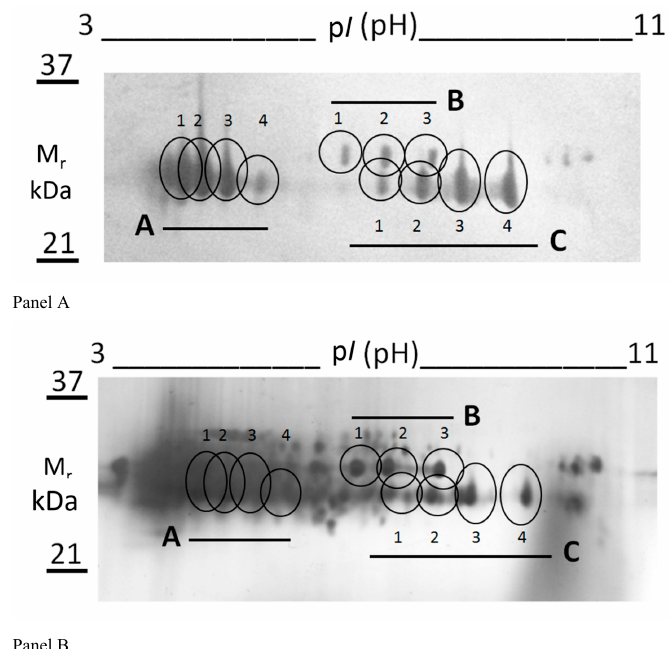
Figure 2. Immuno-proteomic analysis of grape skin proteins with a mass in the range 25–27 kDa. Thirty µ g of RGSM proteins with a mass 25–27 kDa (Figure 1) was extracted from SDS-PAGE and subjected to 2-D electrophoresis, as described in the Materials and Methods section. Gels run in parallel were subjected to WB with anti-peptide Ab (Panel A) or to silver staining (Panel B). The “trains” of spots showing immuno-reactive signals were matched to counterparts in the silver-stained gel, and are labelled as A1-4, B1-3 and C1-4 in both panels. Spots of interest were digested with trypsin and subjected to MS